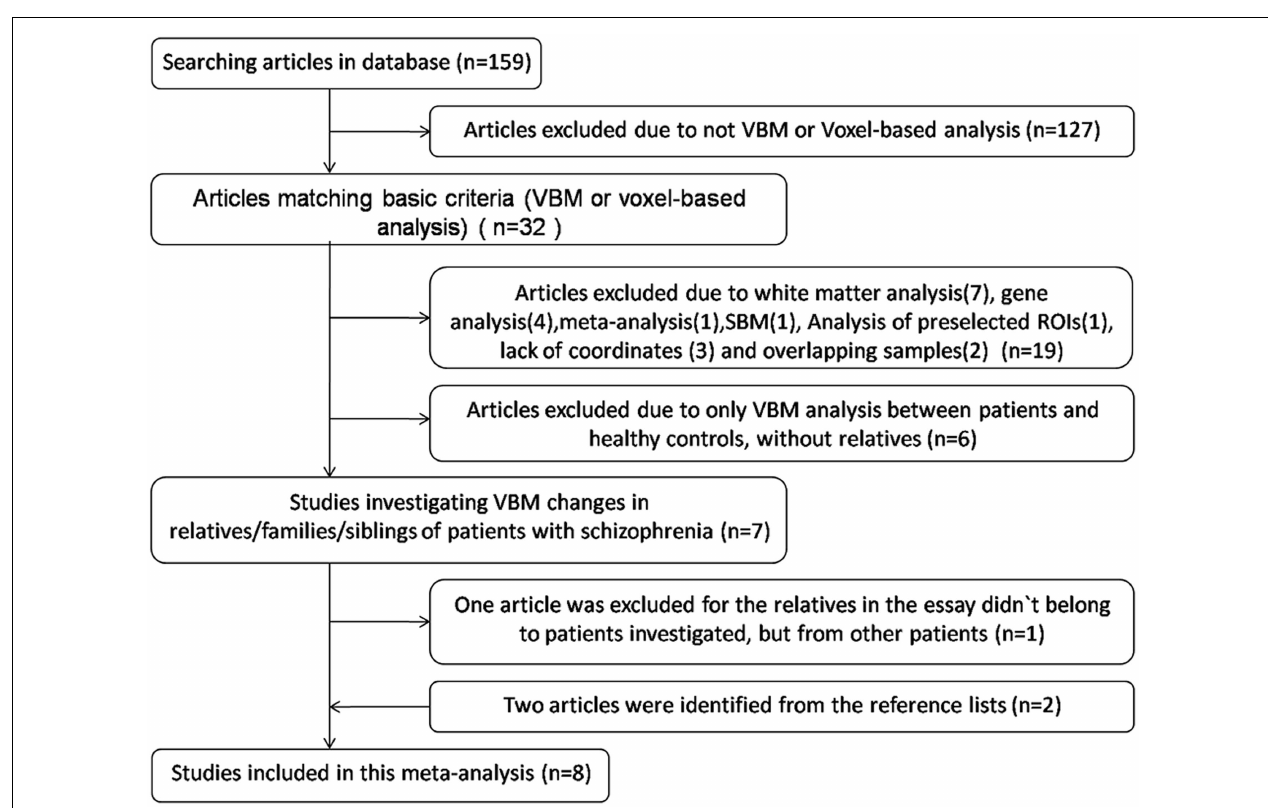
FIGURE 1 | Flow diagram of inclusion and exclusion criteria for the meta-analysis